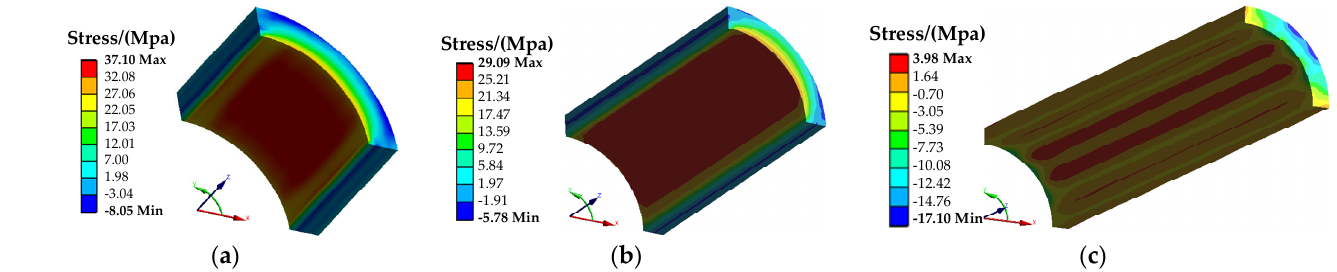
Figure 22. Permanent magnets’ tangential stress distribution under the three cases at rated speed at a hot state: ( a ) Case 1; ( b ) Case 2; ( c ) Case 3. Stress/(Mpa) 48.02 Max 39.90